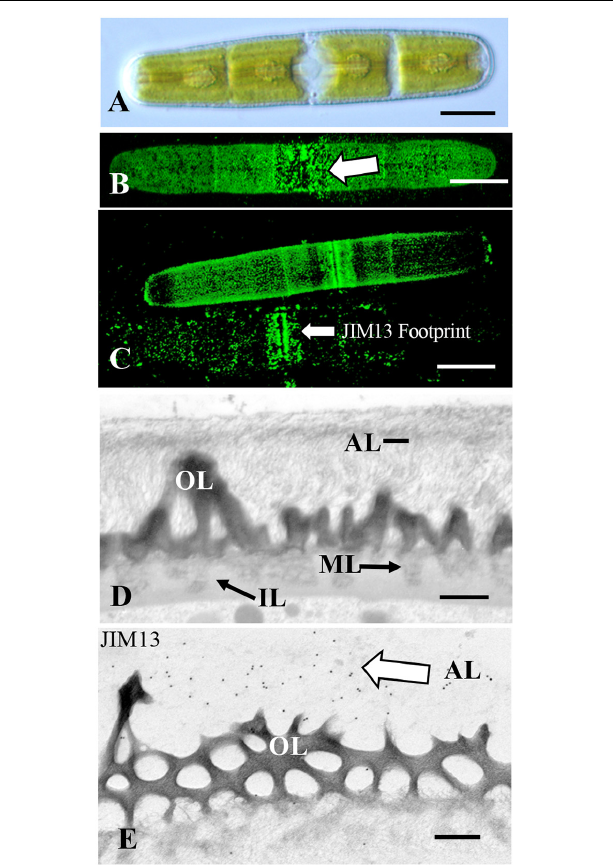
FIGURE 5 | Penium : (A) DIC image of Penium . Bar 12 µ m. (B) JIM13 labeling of the outer surface of the cell wall (arrow). Bar 15 µ m. (C) JIM13 footprint (arrow) of adhesive material left on substrate after removal of cells. Bars 15 µ m. (D) TEM image of the cell wall revealing the pectin-rich outer wall (OL) that connects to a medial layer (ML) that is embedded in an inner layer (IL). External to the outer layer is an adhesive layer (AL) of fine fibrils (arrows). Bar 300 nm. (E) JIM13 labeling (arrow) of the outer adhesive layer (AL) of the wall. Bar 250 nm.